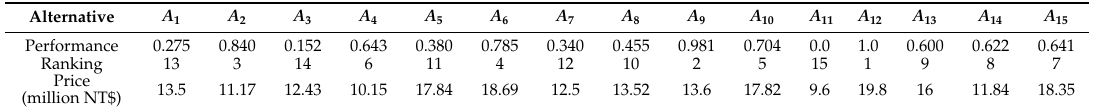
Table 8. Final evaluation performance of